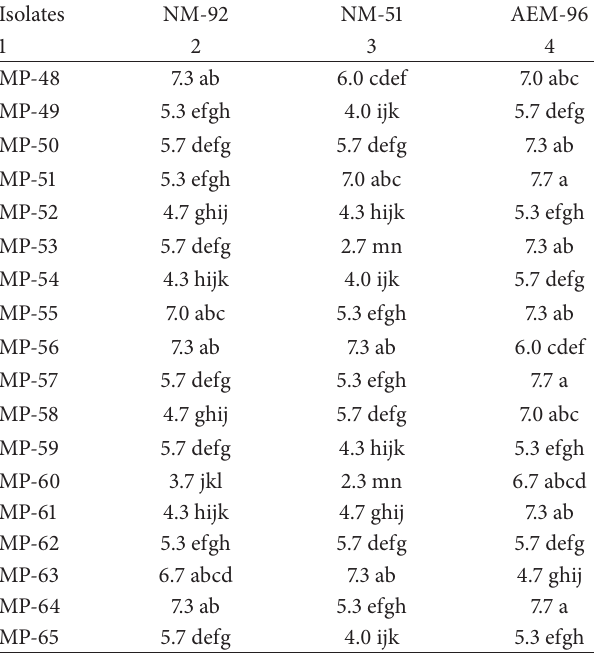
Table 6: Differential response of selected mungbean cultivars against various isolates of M. phaseolina